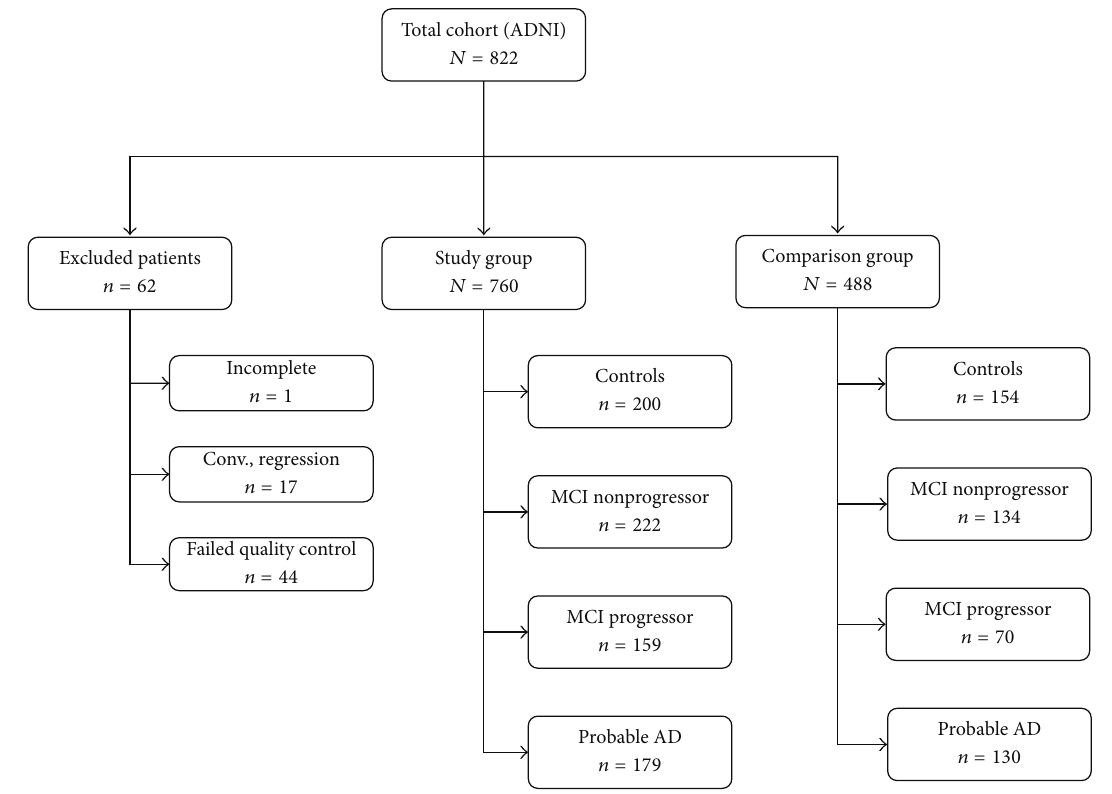
Figure 1: Cohort flow